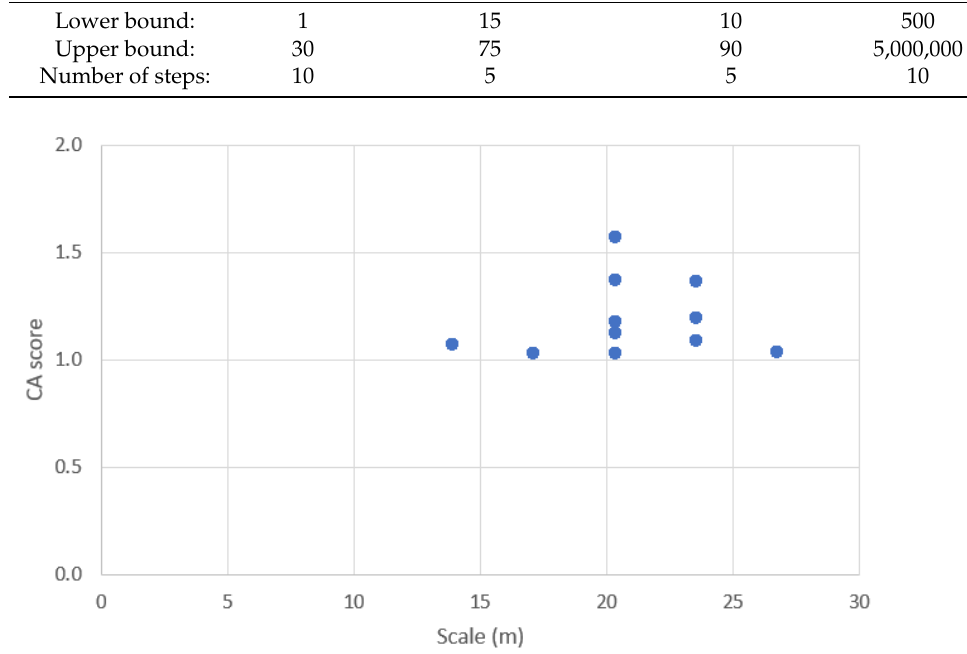
Figure 12. Results of the zoomed in scale (1–30 m) scenario for Heave showing the range of commercially attractive, possible and achievable scales to be between 13–26m.